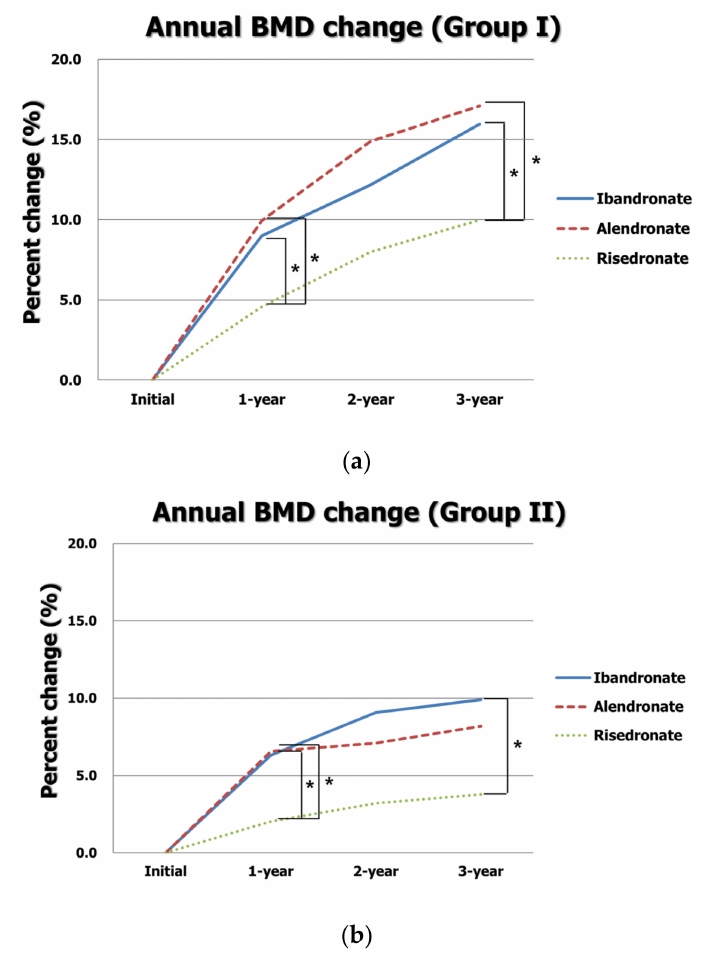
Figure 3. Annual changes in BMD according to type of BP in ( a ) group I and ( b ) group II. * indicates p < 0.05 in a post hoc